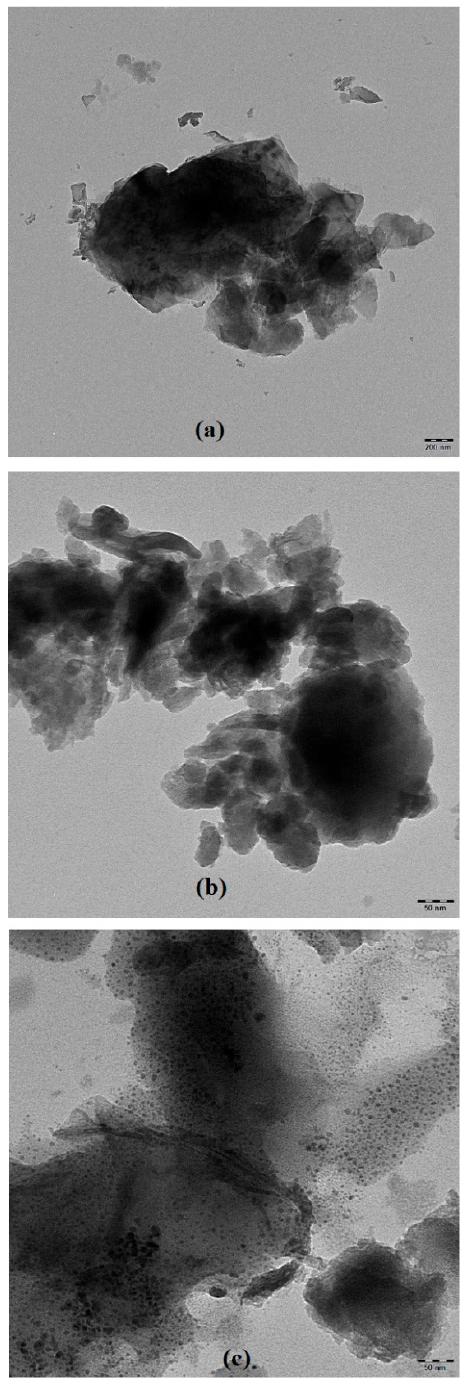
Figure 4. TEM micrographs of MCM-48 and its supported catalysts: ( a ) MCM-48, ( b ) Fe-MCM-48, and ( c ) cellulase-MCM-48.